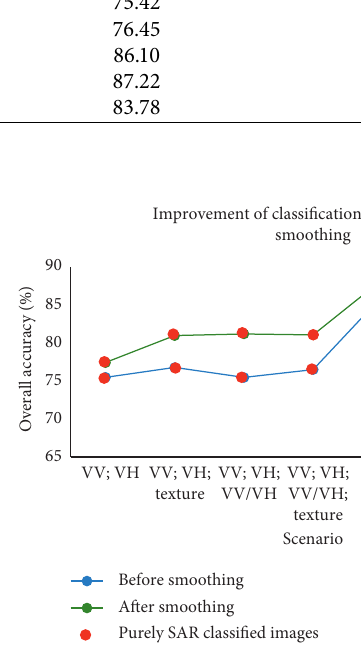
Figure 10: Increased precision of classified images containing radar products that gave the best